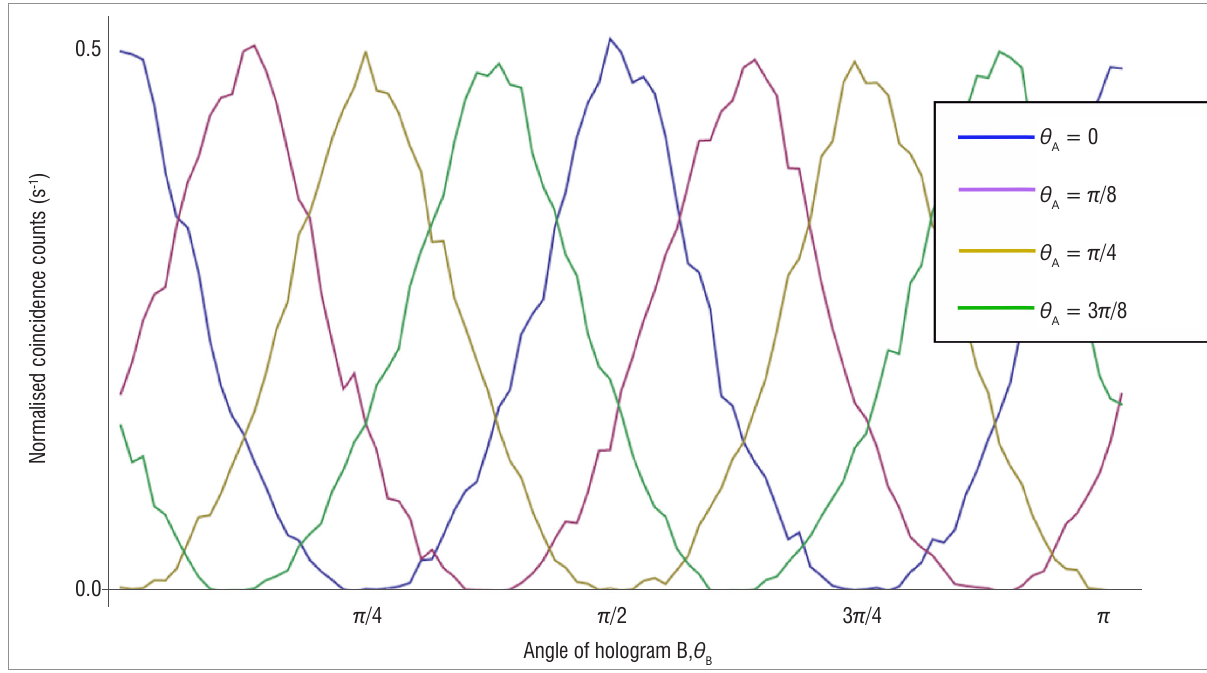
Figure 8: The normalised coincidence counts as a function of the orientation of the holograms on each spatial light modulator (SLM). The orientation of the hologram on SLM A was fixed while those on SLM B were rotated from 0 to π. The photons were projected into the | ℓ |=2